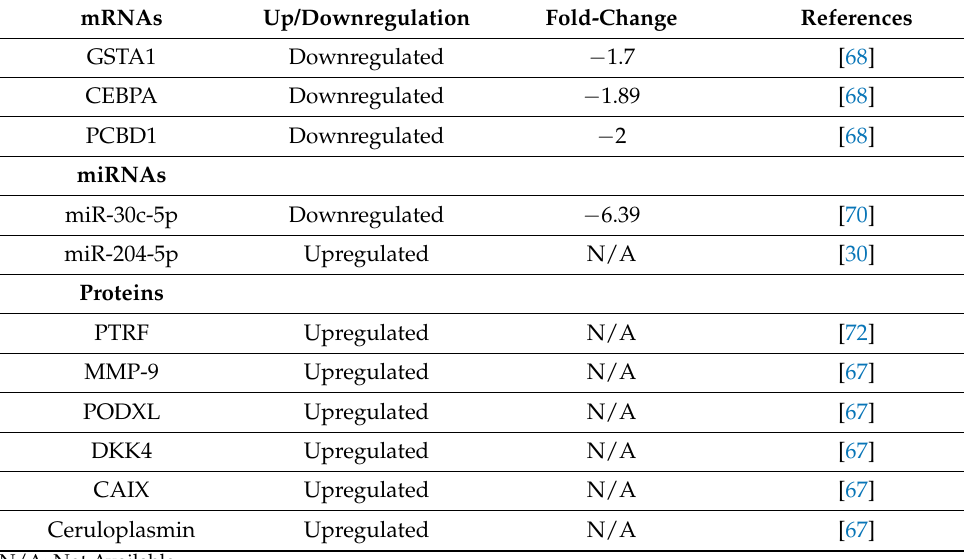
Table 3. EV-associated biomarkers in renal cell